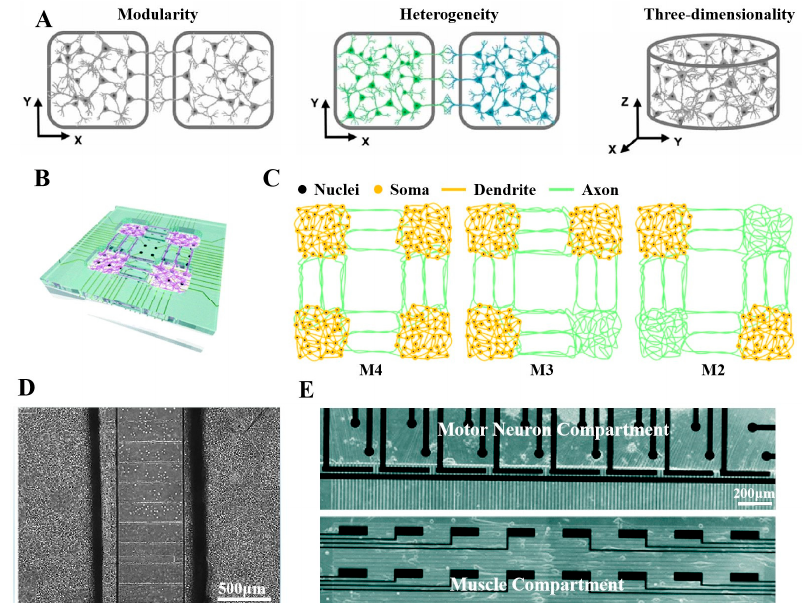
Figure 8. The application of neural chip platforms integrated with microfluidics and microelectrode arrays in the study of simplified brain models. ( A ) An ideal simplified model of the brain in vitro should have the following properties: modularity, co-culturing of heterogeneous cells, and three- dimensional cell cultures [98]. Reproduced with permission from Brofiga, Journal of Neural Engi- neering; published by IOP Publishing, 2021. ( B ) Neural chip platform for modular neuron culturing [27]. Reproduced with permission from Park, Lab on a Chip; published by Royal Society of Chem- istry, 2019. ( C ) Three modes of co-culturing cortical neurons on a neural chip with four culture chambers. ( D ) In vitro brain model of hippocampal–cortex co-cultures [160]. Reproduced with per- mission from Chang, Frontiers in Neuroscience; published by Frontiers, 2022 (from Chang et al., 2022). ( E ) In vitro brain model co-cultured with motor neurons and muscle cells [61]. Reproduced with permission from Duc, Lab on a Chip; published by Royal Society of Chemistry, 2019. Table 1. Several typical neural chips and their applications.